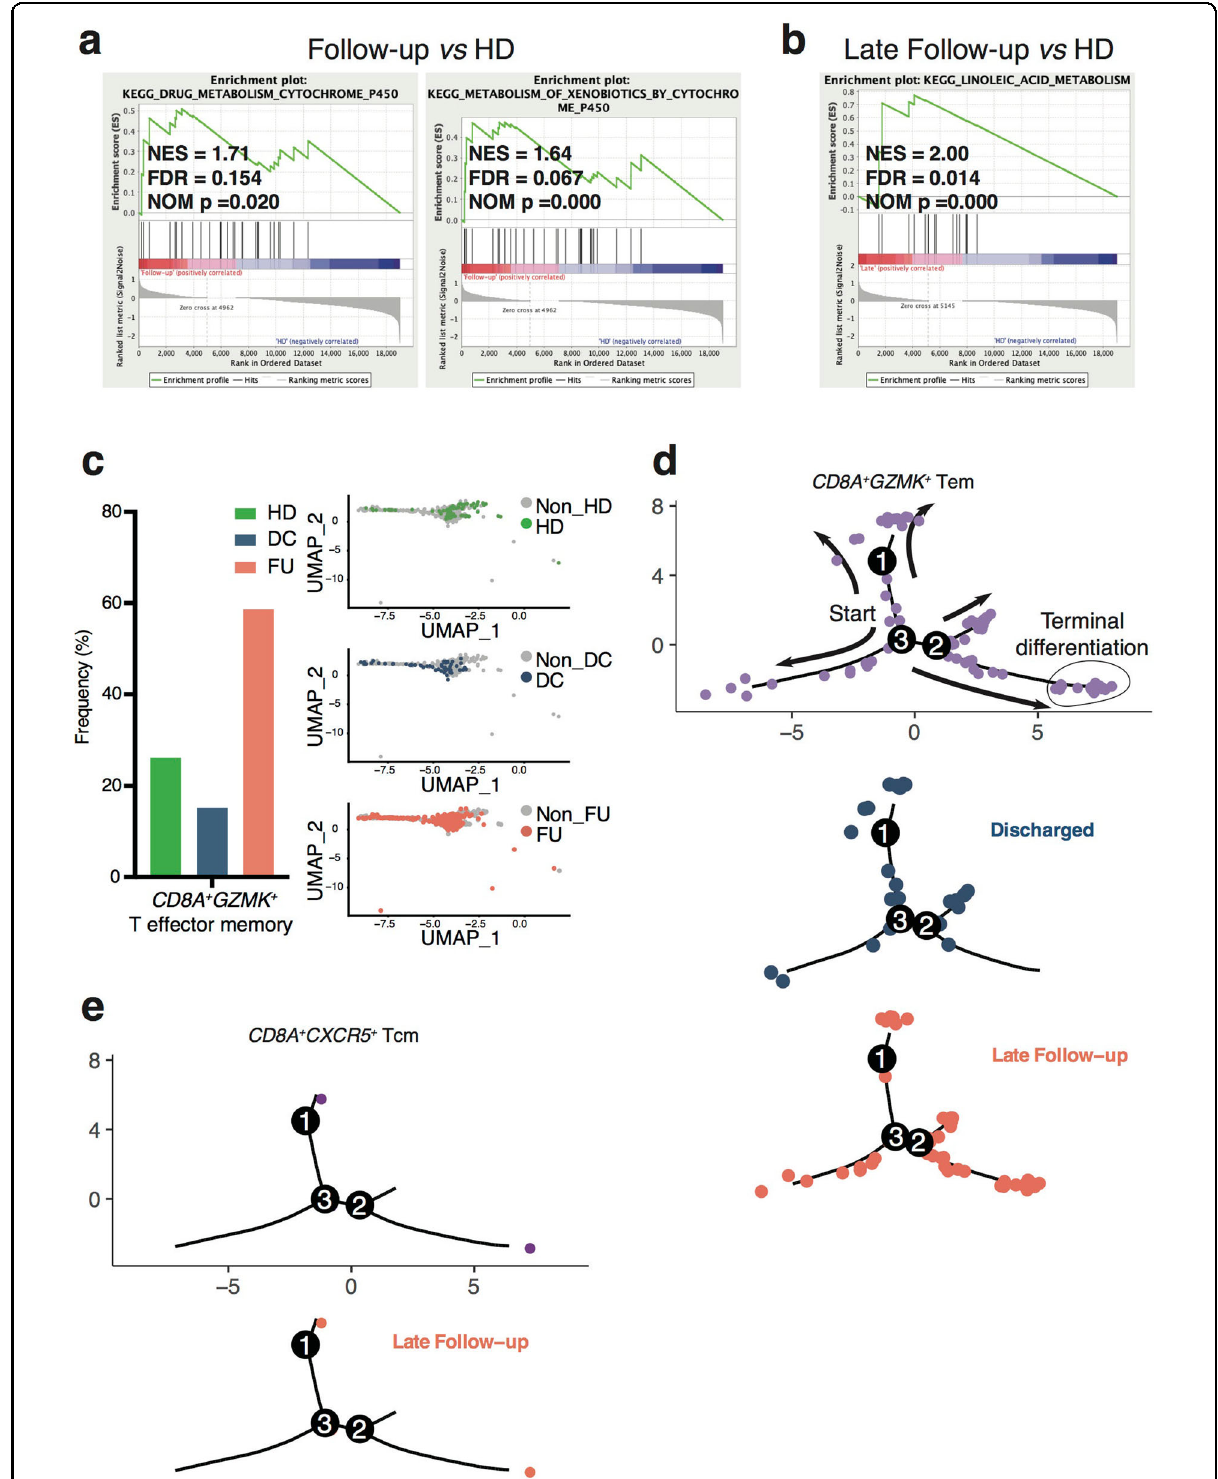
Fig. 6 (See legend on next